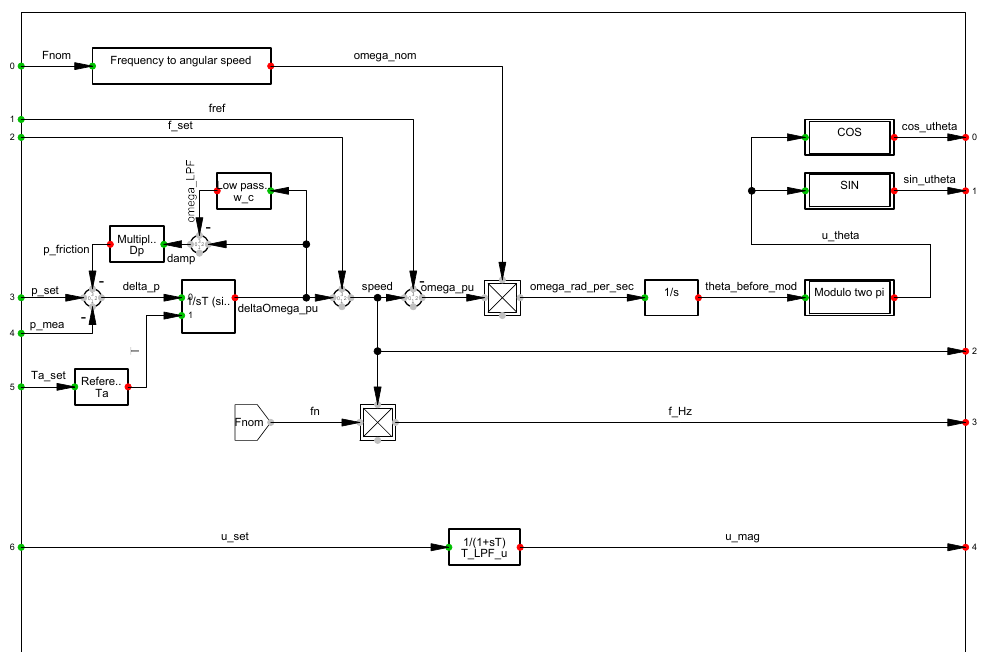
Figure A2. Virtual synchronous machine (VSM). See Section 4.2 for